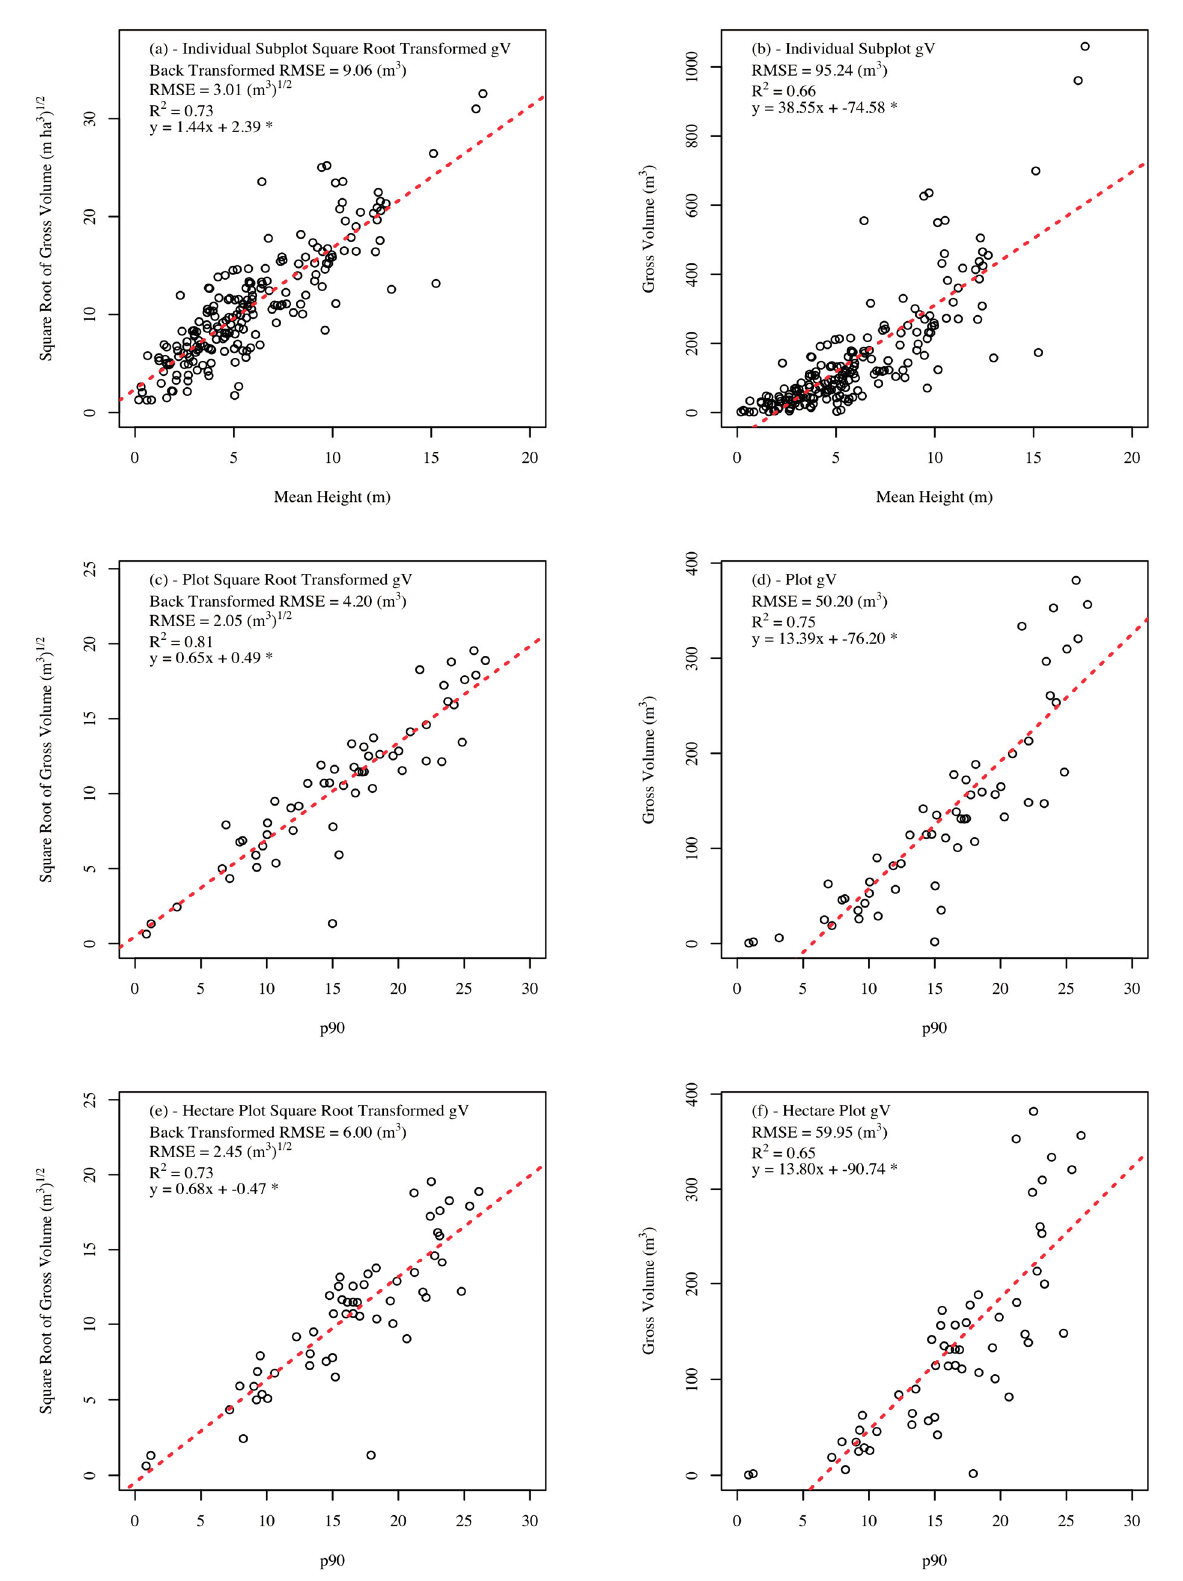
Figure 8. Scatter plot of simple linear regression results for the best simple linear regression gross volume models (transformed and non-transformed) for individual subplots ( a , b ), plots ( c , d ), and hectare plots ( e , f ). * indicates p -values of less than